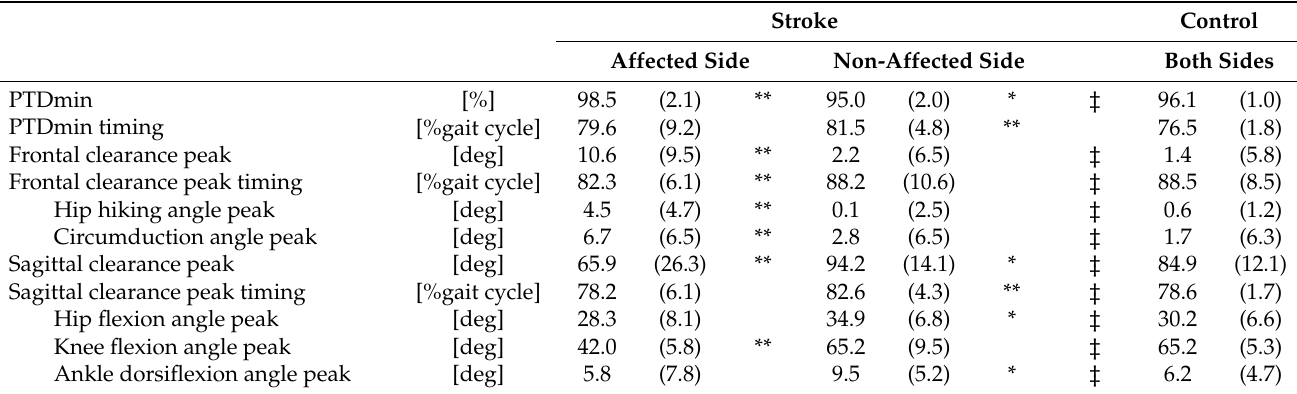
Table 2. Summary of kinematic